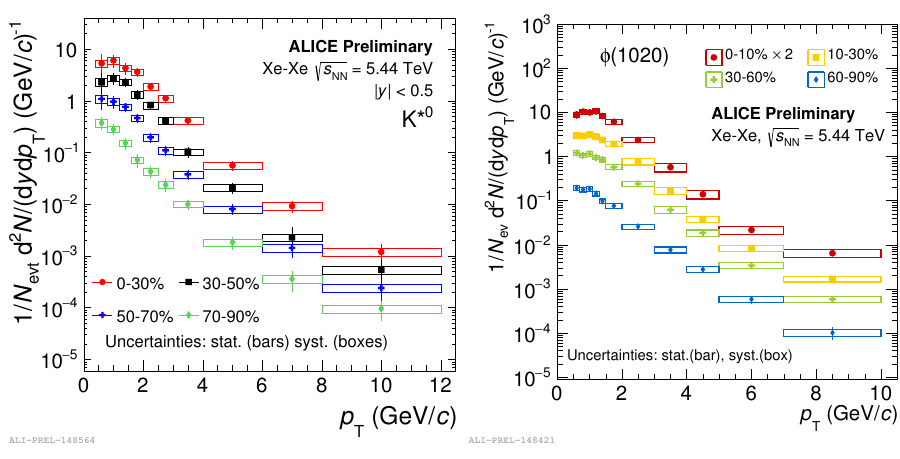
Figure 1. (color online) Transverse momentum spectra for K ∗ 0 (left) and φ (right) in di ff erent centrality √ s NN = 5.44 TeV classes of Xe-Xe collisions at